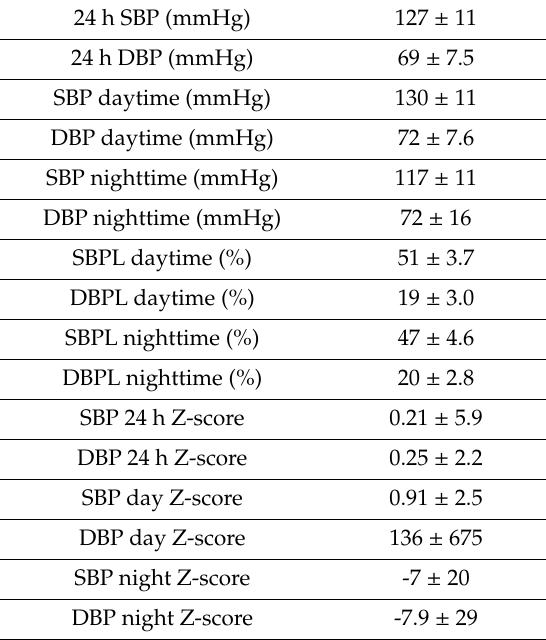
Table 2. Summary of ABPM profiles in hypertensive children.